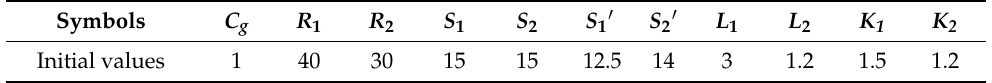
Table 4. The initial values of external variables in the SD